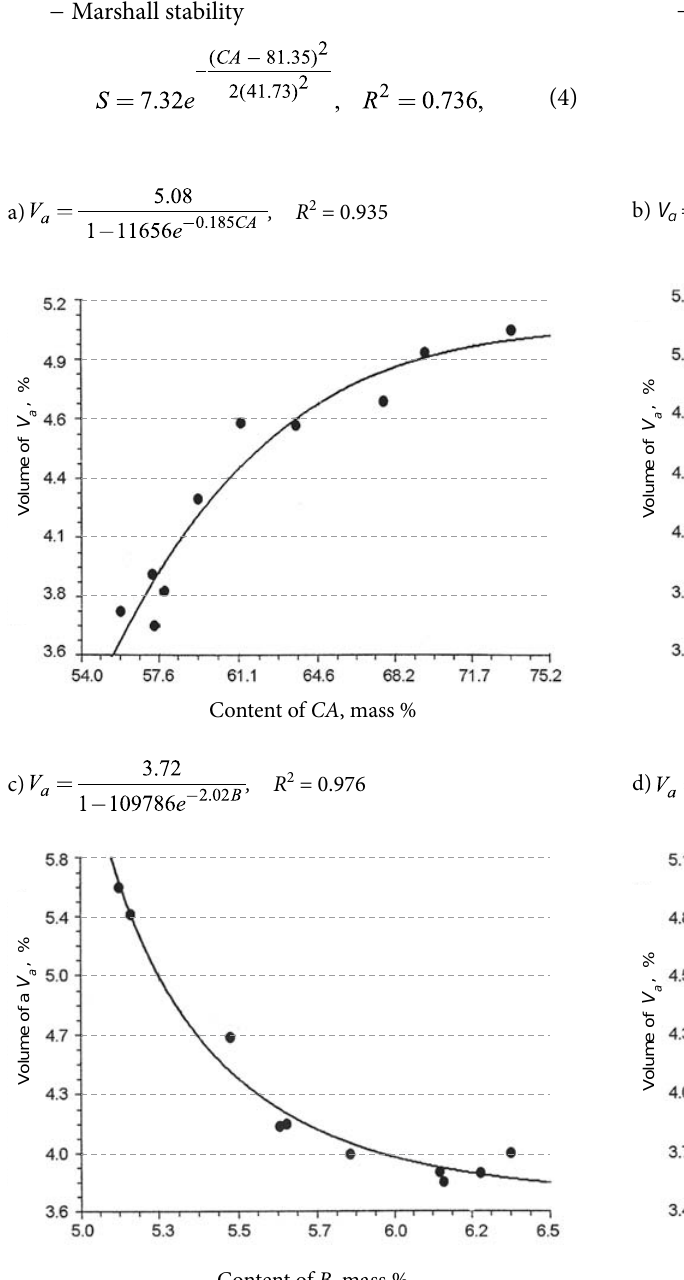
Fig. 1. Relationship between V a in motor road pavement and content of its components: a – CA ; b – MF ; c – B, mass %; d